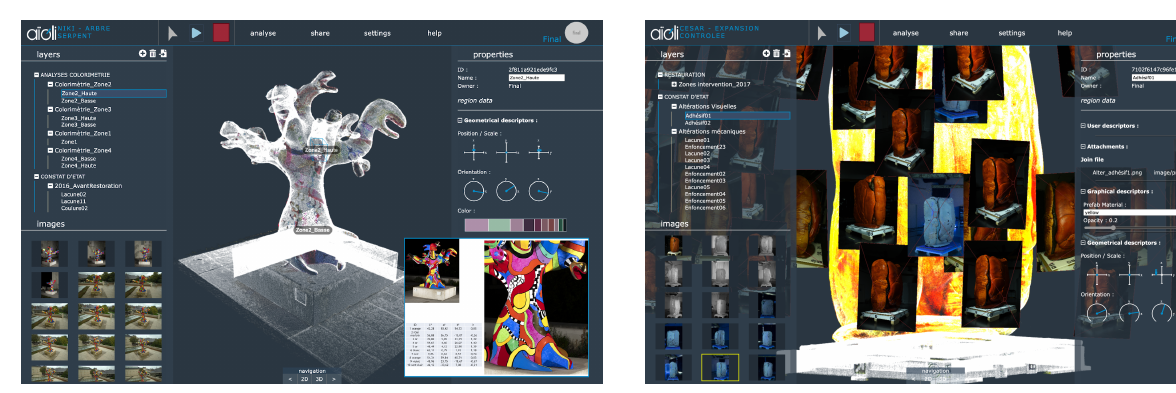
Figure 8 . Correlation of joint spectroscopic analysis and color-palette from the dense cloud on « Arbre aux serpents »